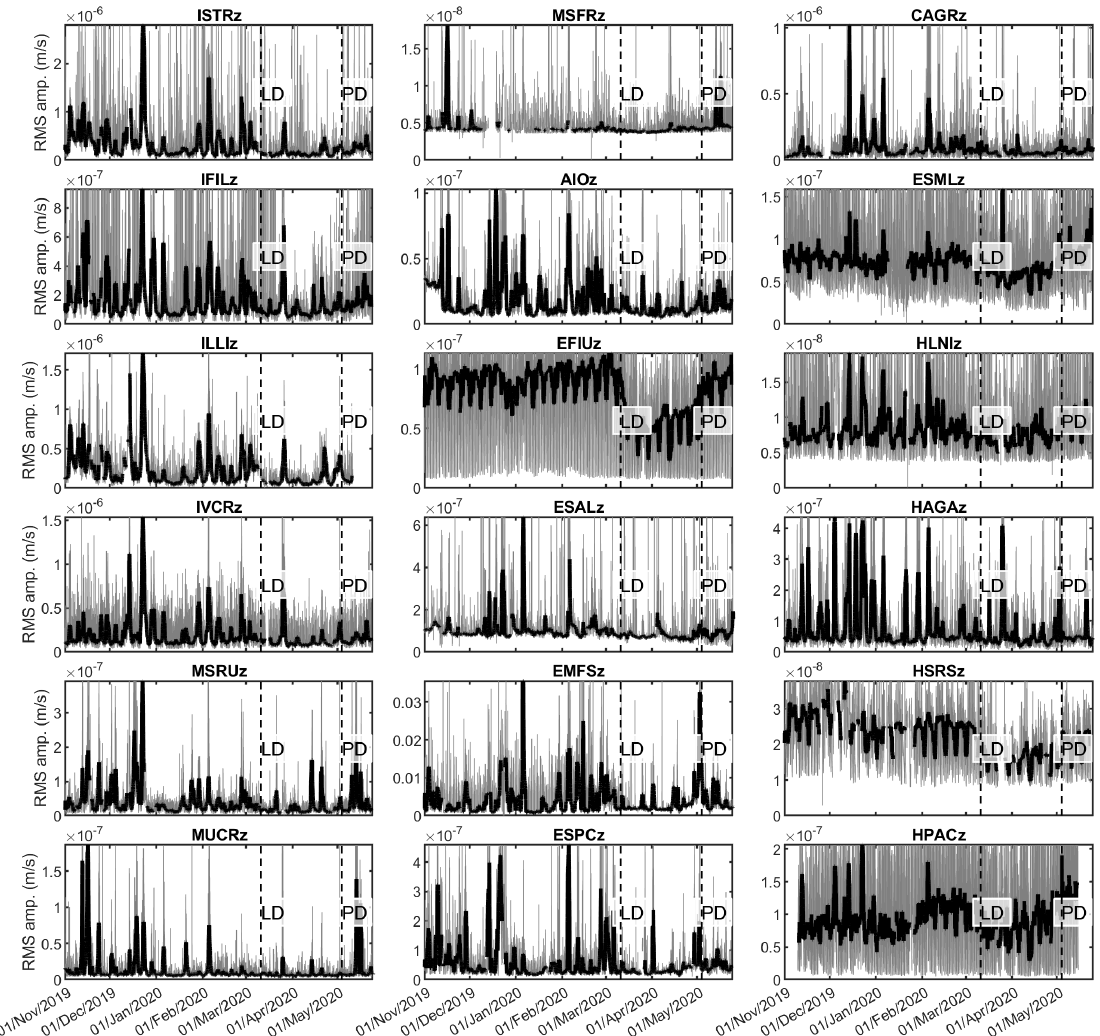
Figure 3. Rms amplitude time series of the vertical component of the seismic signals, filtered in the band 10–40Hz (grey line), and corre- sponding moving median computed on 1d long sliding windows (thick black line). The vertical dashed lines and the labels “LD” and “PD” indicate the times when the national lockdown measures were implemented in Italy (11 March 2020) and when the first presidential decree, slightly lifting the lockdown measures, was issued (4 May 2020), respectively. The stations are sorted by decreasing latitude from upper left to bottom